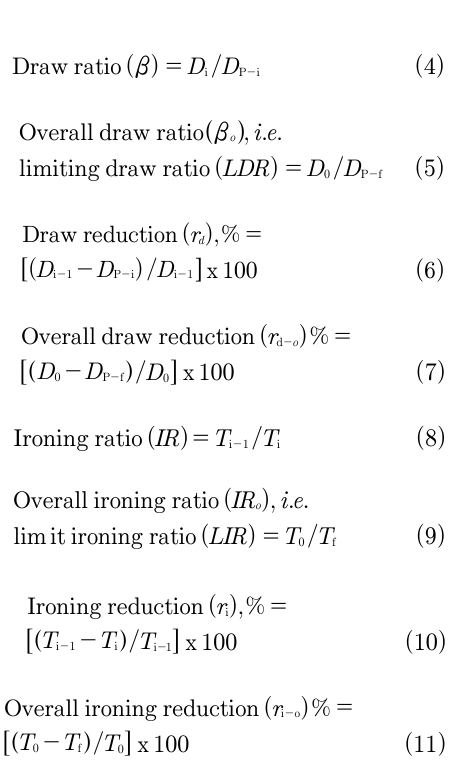
dispersibility 19, 27-29 . The uniaxial formability characteristics evaluation shows its r -value, 1.1 (>1), and ∆ r -value, m